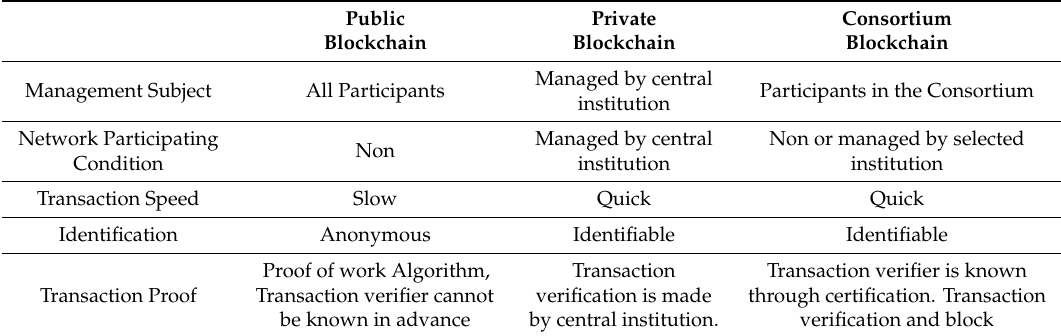
Table 1. Type of Blockchain.